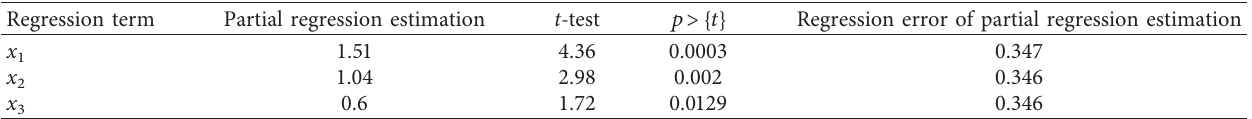
Table 14: Estimation of the partial regression coefficient of y modified with raw soil.